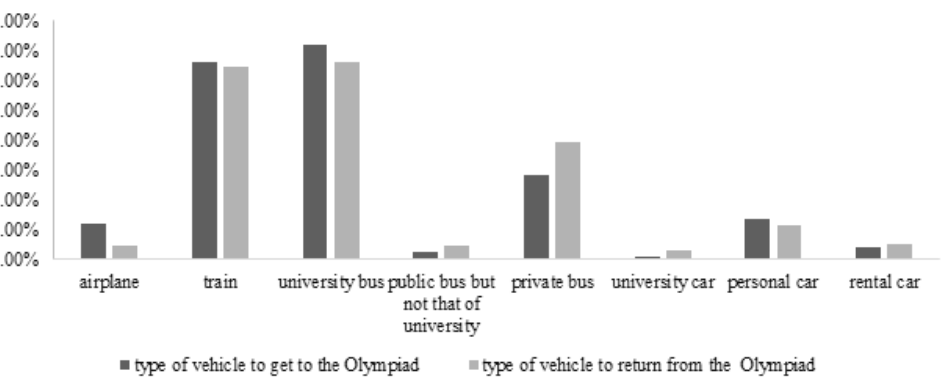
Figure 3. Type of vehicles used to get to and return from the city hosting the